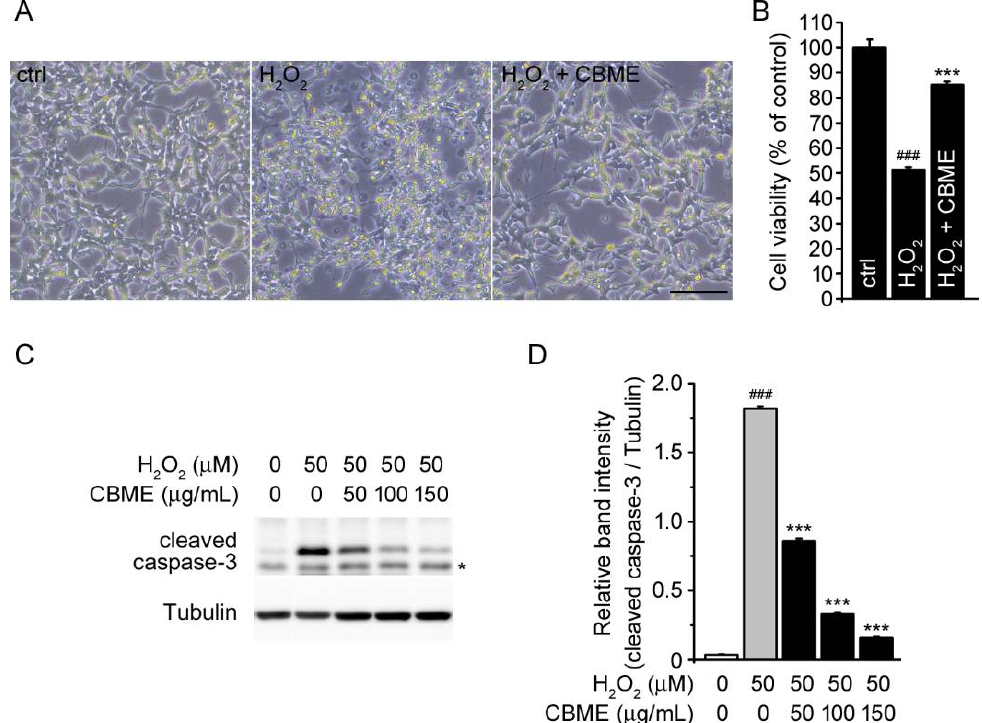
Figure 2. Effects of Chrysanthemum boreale Makino extract (CBME) on H 2 O 2 -induced neural damage in SH-SY5Y cells. ( A ) Microscopic image of SH-SY5Y cells with or without 3 h pretreatment with CBME (150 µg/mL) and subsequently exposed to 50 µM H 2 O 2 for an additional 24 h. The representative image was obtained by phase-contrast microscopy. Scale bar = 100 µm. ( B ) Cell viability was evaluated using the WST-1 assay in the same conditions as ( A ). ( C ) Western blot bands corresponding to cleaved caspase-3 in SH-SY5Y cells which were pre-treated with the indicated concentrations of CBME for 3 h and then exposed to H 2 O 2 for 24 h (* denotes non-specific band). Tubulin was used as the loading control. ( D ) Relative band intensity of cleaved caspase-3 was quantified using densitometric analysis and then normalized to that of tubulin. Values in the bar graphs are the mean ± SEM of at least three independent experiments. *** p < 0.005, significantly different from the H 2 O 2 group. ### p < 0.005, significantly different from the control group. H 2 O 2 , a well-known substance generated by oxidative stress, can evoke neuronal cell death by acting as a mediator of apoptosis [25–29]. Caspase-3, a member of the